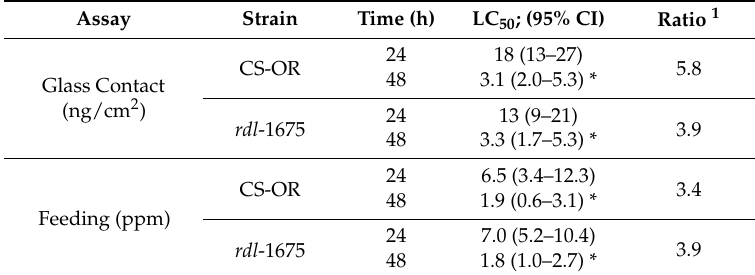
Table 6. Glass contact and feeding bioassays of fluralaner against susceptible and resistant adult D. melanogaster strains. D. melanogaster strains.